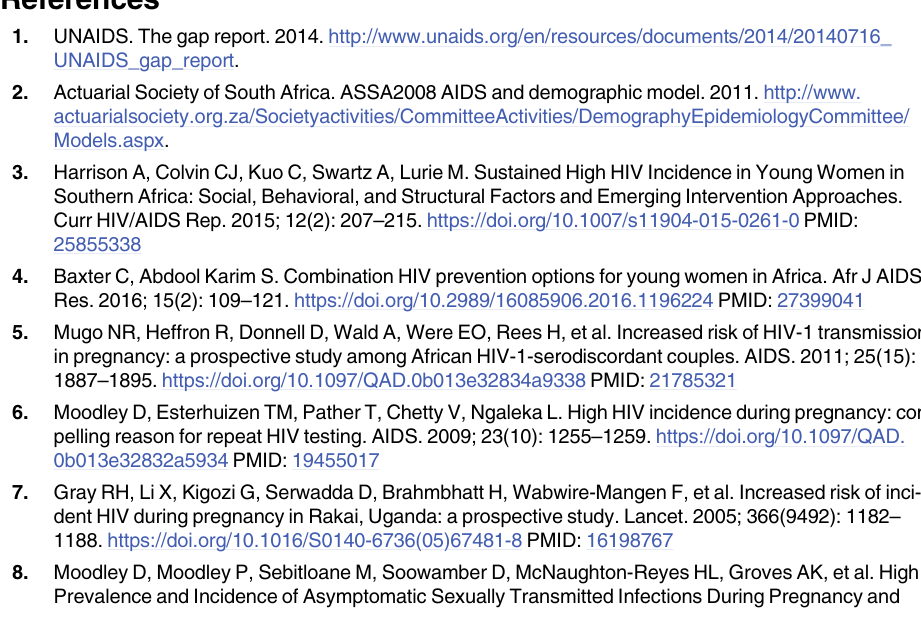
S1 Fig. Flow chart of women included and excluded from analyses.